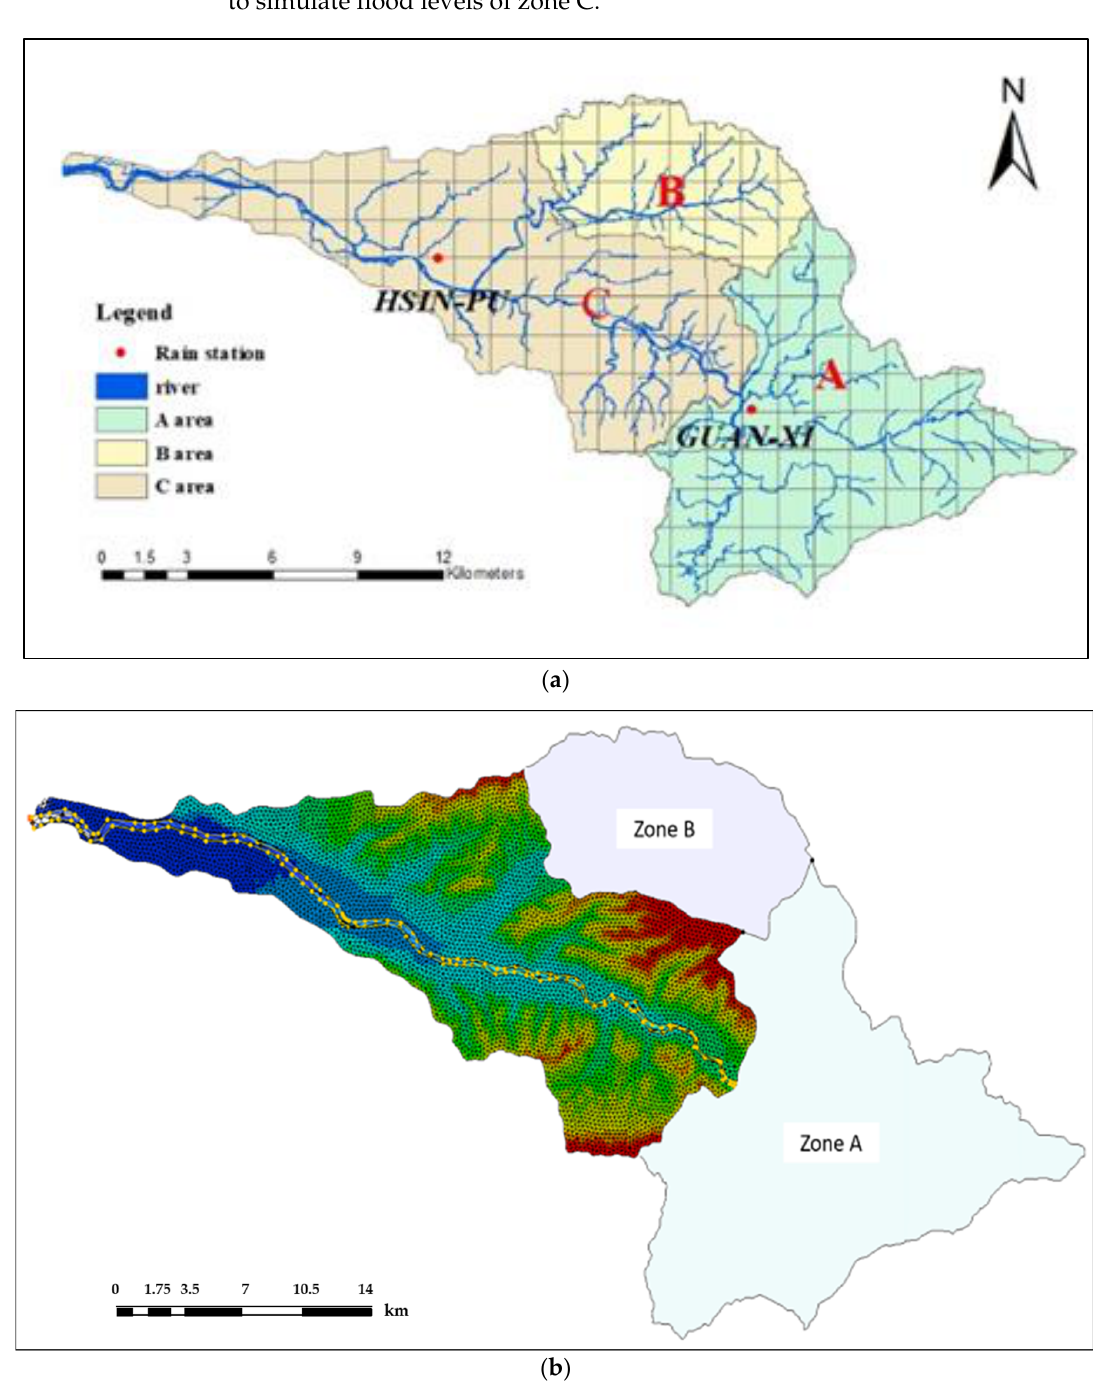
Figure 4. Conceptualization of the study area for model application, zones (A and B) in HEC-HMS and zone C in WASH123D ( a ) Mesh construction from radar grid points ( b ) grid constructions of WAH123D [13].